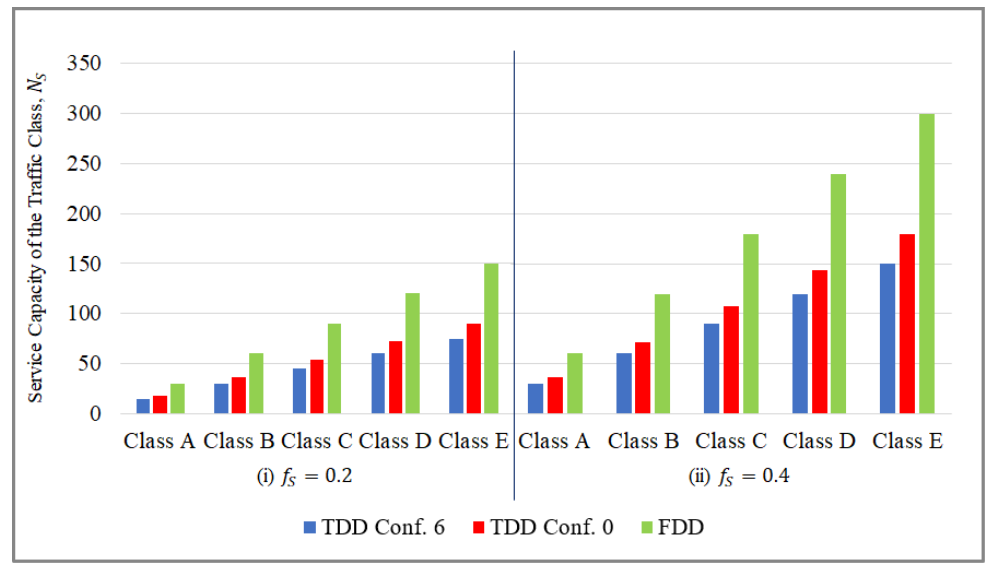
Figure 9. Service capacity N S of 5 traffic classes in single-class environment.